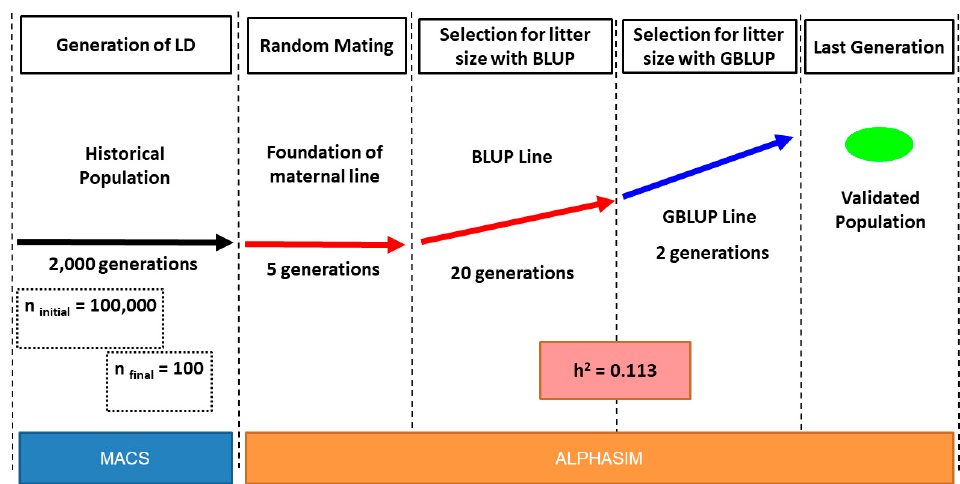
Figure 1. Design of simulations. A first period, generating the linkage disequilibrium (LD) across the rabbit genome using MaCS program. The remaining periods are carried out using AlphaSim : foundation of maternal line, selection for litter size with Best Linear Unbiased Prediction (BLUP), and with Genomic Best Linear Unbiased Prediction (GBLUP).